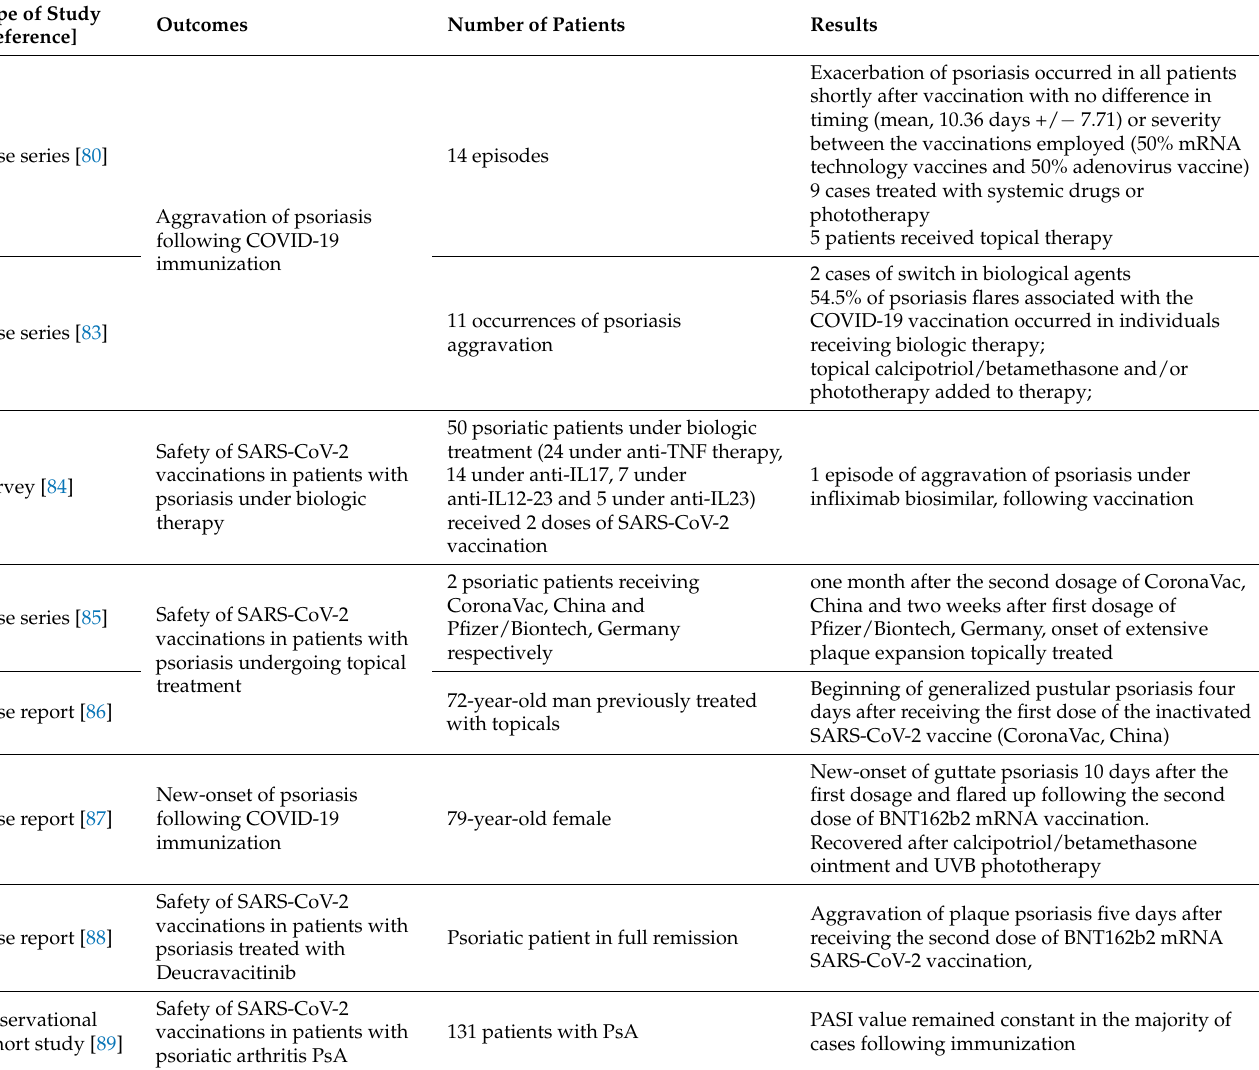
Table 4. Impact of SARS-CoV-2 vaccines on patients with